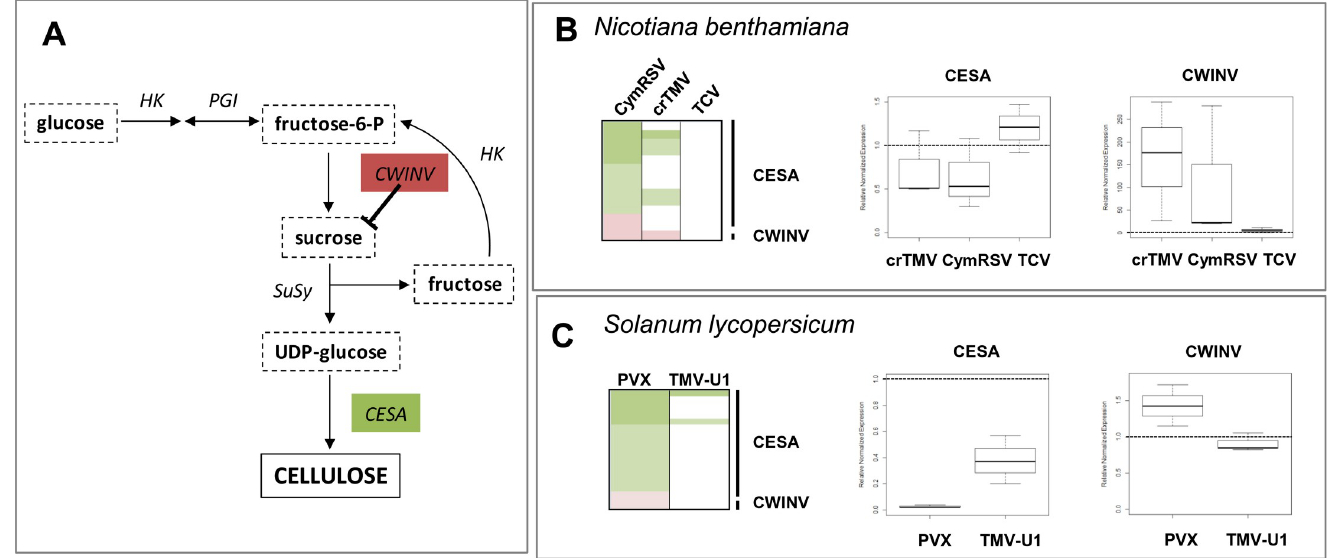
Fig 6. Investigation of the gene expression changes in cell wall metabolism. (A) Schematic diagram of cellulose synthesis pathway; (B, C) heat maps show gene expression changes of the investigated genes (left panels upregulation: red, downregulation: green). Whisker diagrams show delta-delta Ct results of qRT-PCR from 3 biological and technical replicates using ubiquitin as an internal control (middle and right panels). The DEPs and DEGs on the heat map are listed in S13 and S14 Tables with their characteristic parameters. (HK: hexokinase; PGI: phosphoglucose isomerase; CWINV: cell wall invertase; SuSy: sucrose synthase; CESA: cellulose